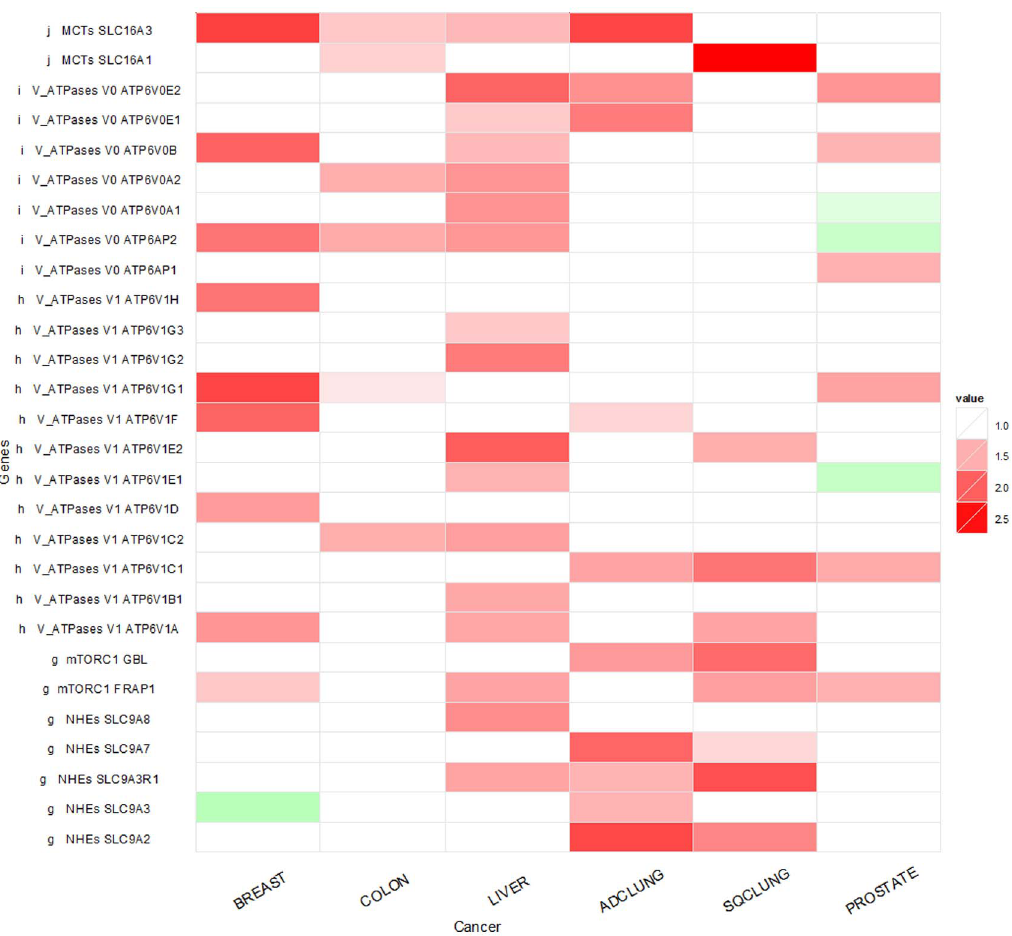
Figure 1. Expression-level changes of V-ATPase and related genes in six cancer types in comparison with their matching control tissues. Each entry in the table shows the ratio between a gene’s expression levels in cancer and the matching control, averaged across all the samples.